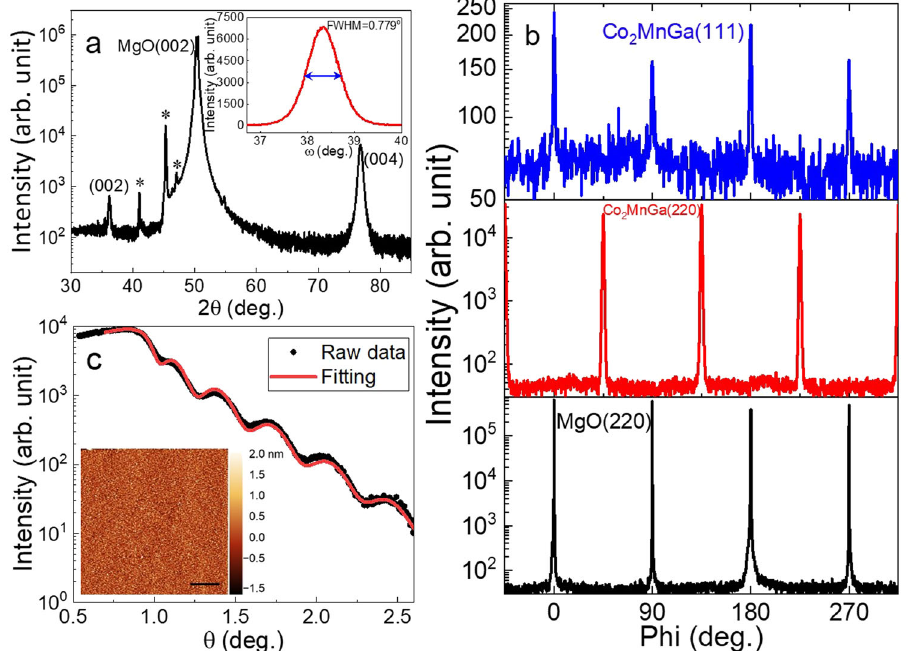
Fig. 1 Crystal structure and surface morphology of Co 2 MnGa. a θ – 2 θ scan, the inset is the rocking curve from (004) peak, and b in-plane φ scans from − 45° to 315°, for 50 nm Co 2 MnGa thin fi lms. c X-ray re fl ectivity for the 20 nm Co 2 MnGa thin fi lm, the inset is the atomic force microscopy image (5 × 5 µm 2 ) with colour contrast (dark to bright) for the height scale corresponds to 3.5 nm. The scale bar corresponds to 1 μ